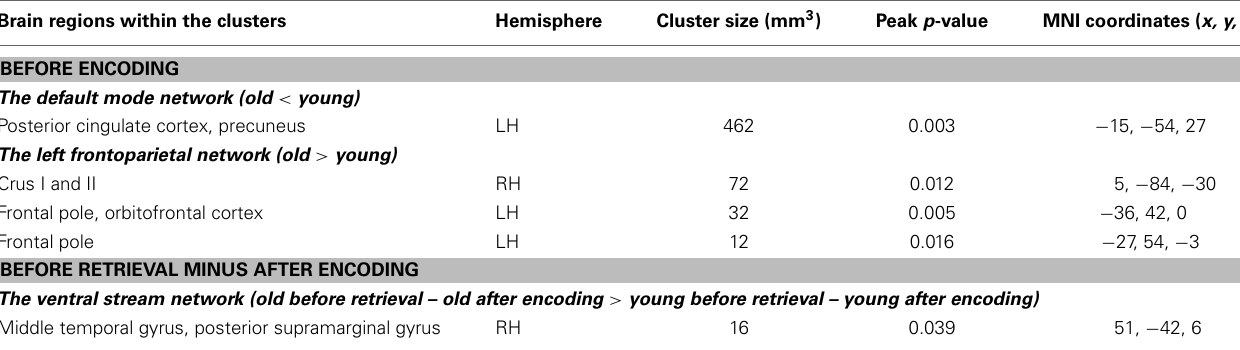
Table 5 | Group differences in task-free connectivity within the networks of interest.